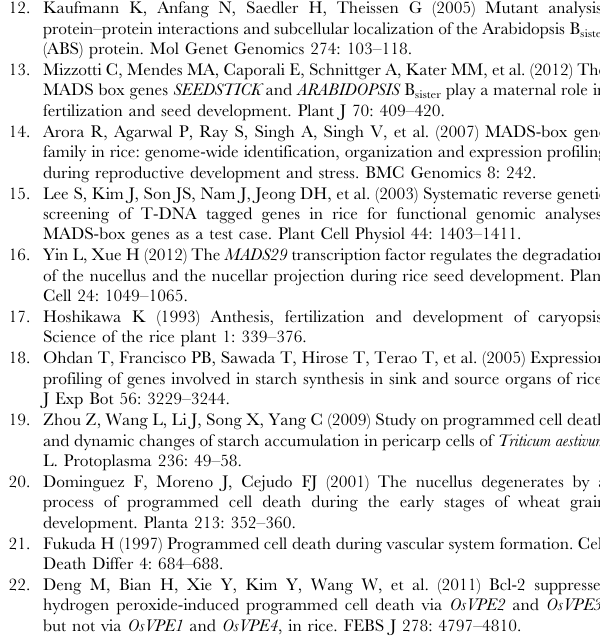
Figure S1 Accession numbers of genes used in the phylogeny trees. Figure S2 Expression detections for the selected genes related to the starch synthesis. Quantitative real-time PCR analyses of ADP- glucose pyrophosphorylase genes in young seeds (10 DAP) of control and RNAi transgenic plants. ACTIN1 was used as an internal control. Error bars indicate the SD (n= 3). Figure S3 Longitudinal sections of ovule and embryo of control and RNAi transgenic plants. ( A ) . Longitudinal sections of mature ovule (OV10) in control plant. ( B–E ) . Longitudinal sections of embryo of developing seeds in control plants at 1, 3, 5, and 7 DAP, respectively. ( F ) . Longitudinal sections of mature ovule (OV10) in RNAi transgenic plant. Bar= 20 m m.